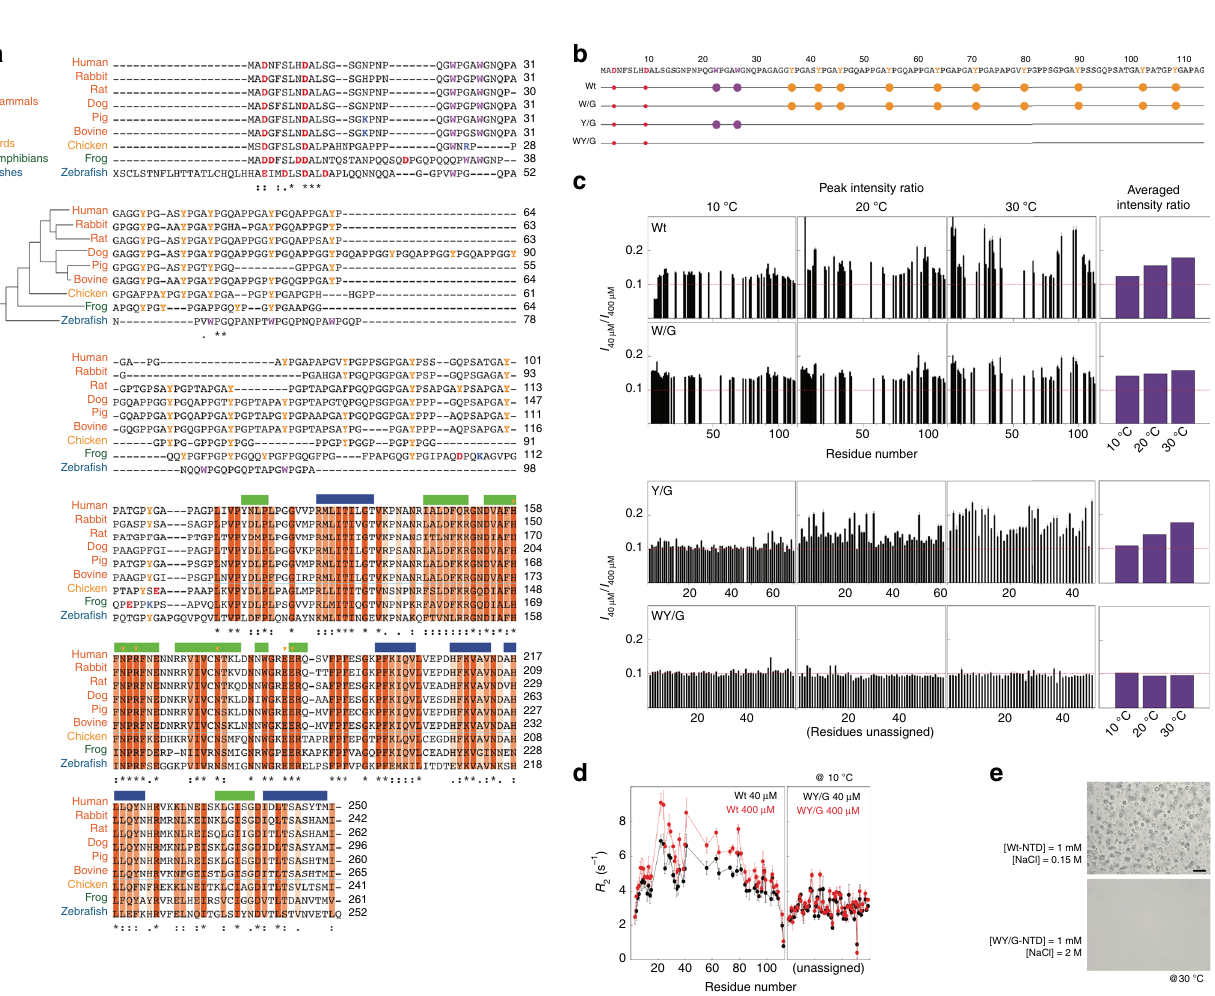
Fig. 3 The key residues that mediate intermolecular N-terminal domain (NTD) interactions. a Alignment of galectin-3 amino-acid sequences from different vertebrates (human, fi ve mammals, one bird, one amphibian, and one fi sh). The phylogenetic tree is plotted based on a summary of multigene and multiprotein studies 87 . Residues in the carbohydrate recognition domain (CRD) are highlighted with dark, medium, or light orange depending on their level of conservation. Negatively and positively charged residues, tyrosines, and tryptophans in the NTD are colored in red, blue, yellow and purple, respectively. b Amino-acid sequences of the constructs used in this study with negatively charged residues, tryptophans, and tyrosines highlighted by solid red, purple, and yellow circles, respectively. c NMR peak intensity ratios between 40 and 400 µ M samples at 10, 20, and 30 °C for the four NTD constructs. The average peak intensity ratios at each temperature are shown in the right-most panel. Red dashed lines indicate the intensity ratio expected from the molar ratio (0.1). d Transverse relaxation rate constants for the 40 (black) and 400 (red) µ M wild-type and WY/G mutants at 10 °C. e Micrographs of samples of wild-type galectin-3 and the WY/G construct under conditions corresponding to the two-phase regime in the wild-type phase diagram (Fig. 2e; scale bar: 50 µ m). Experiments were performed at least three times for each protein constructs (because of the many repeated amino-acid motifs) would have made assignment dif fi cult. Overlapping peaks also provide limited residue-speci fi c information. In these constructs, we therefore only analyzed the well-resolved peaks to avoid bias due to peak overlap.